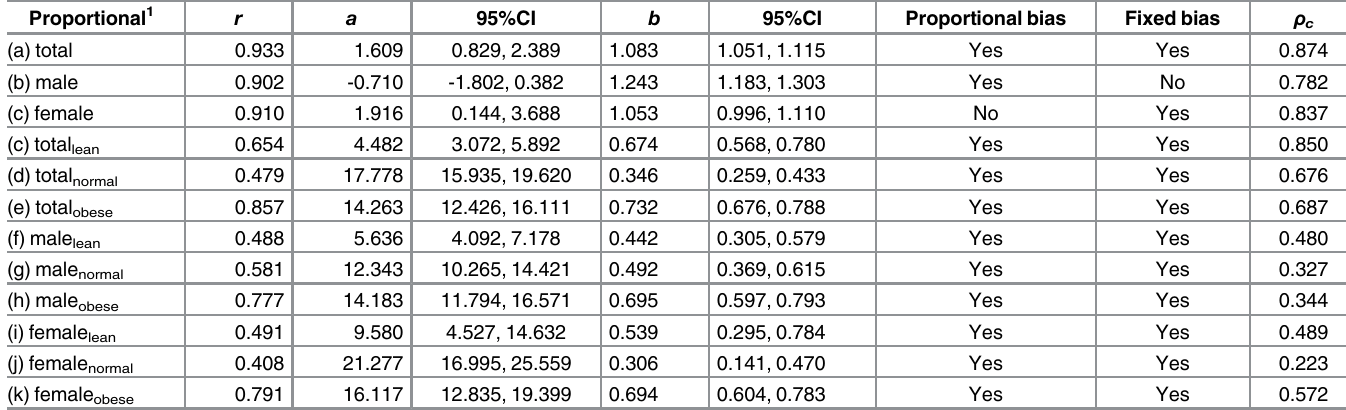
r , product-moment 1 Relationship between different subgroups in BF% DXA and BF% BIA8 , lean, normal, obese subscripts represents DXA measured results; correlation coef fi cient; a, b, coef fi cients in ordinary least products regression model E(A) = a + b (B); a , A (y axis) intercept; b , slope; proportional bias, if 95% con fi dence interval (CI) for b does not include 1; fi xed bias, if 95% CI for a does not include; Lin ’ s concordance correlation coef fi cient ( ρ c